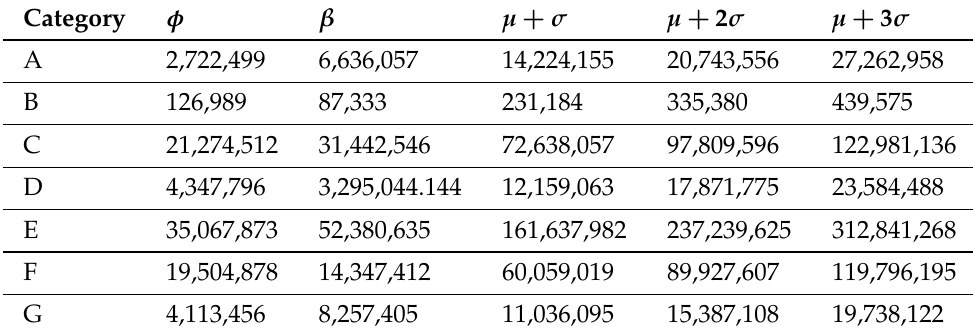
Table 19. Optimization of total medical benefit for each Category A,B,C,D,E,F and